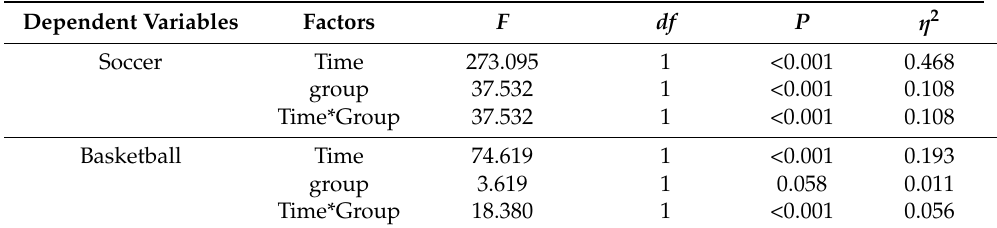
Table 2. Results of the repeated measure of the ANCOVA and the ANOVA for manipulative skills between the two